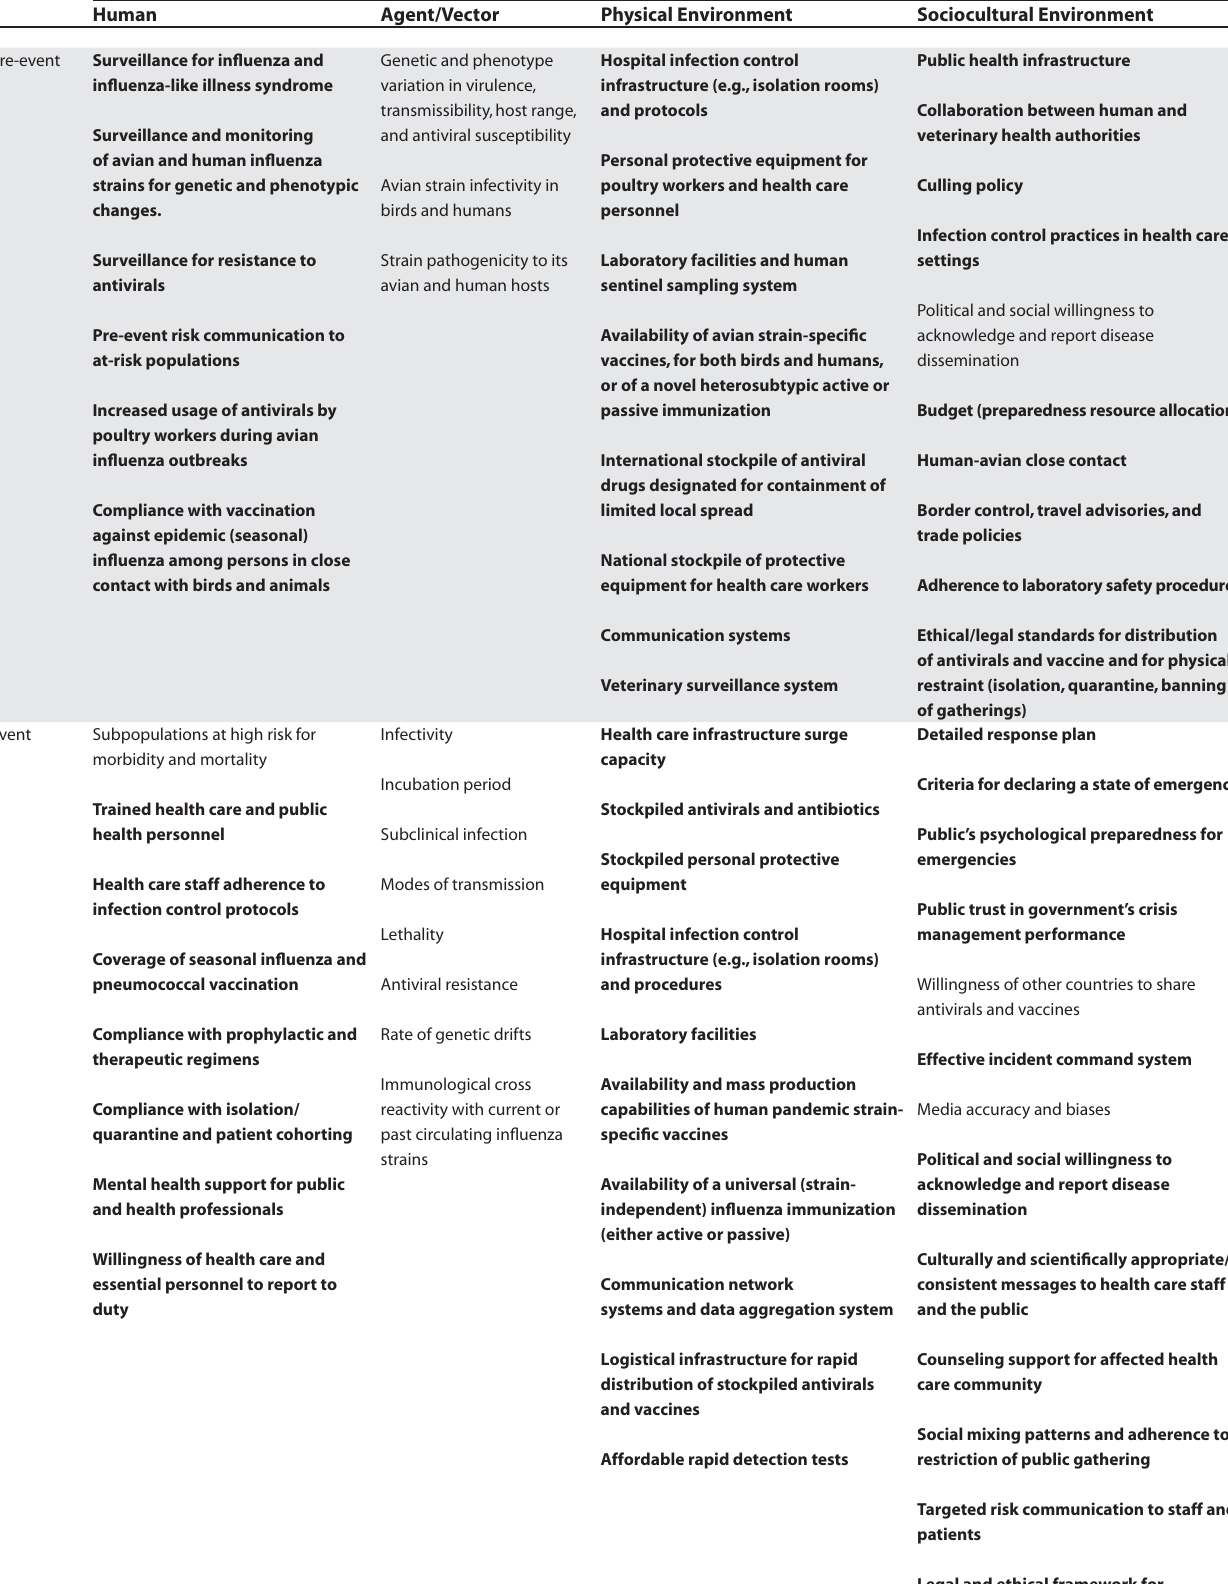
Table 1. The Haddon Matrix and Pandemic Avian Infl uenza Phase Factors